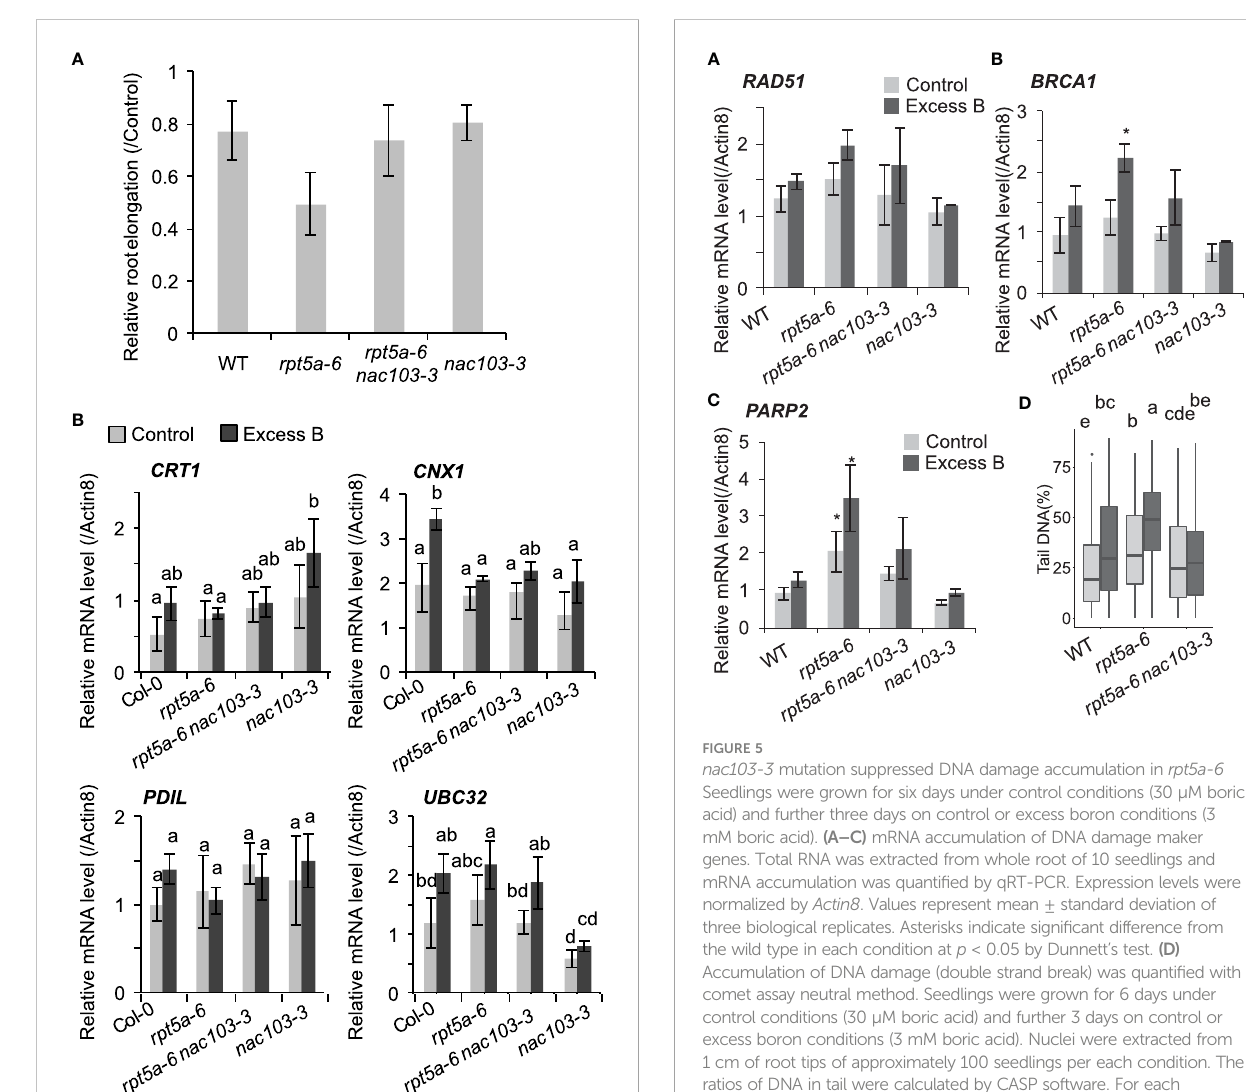
FIGURE 4 Effect of nac103-3 mutation on unfolded stress response (A) Sensitivity to unfolded protein inducible reagent L-canavanine. Seedlings were precultured in normal conditions (30 µM boric acid) for six days and then transferred to 0.5 µM L-canavanine or control conditions. Root elongation during three days after the transfer was measured and normalized by the average elongation under control conditions. Values represent mean ± standard deviation of measurements of 11-15 seedlings. An asterisk indicates signi fi cant difference from the wild type at p < 0.05 by Dunnett ’ s test. (B) mRNA accumulation of NAC103- downstream unfolded protein response related genes, CRT1, CNX1, PDIL1 and UBC32 . Seedlings were grown for 6 days under control conditions (30 µM boric acid) and further 3 days on control or excess boron conditions (3 mM boric acid). Total RNA was extracted from whole root of 10 seedlings and mRNA accumulation was quanti fi ed by qRT-PCR. Expression levels were normalized by Actin8 . Values represent mean ± standard deviation of three biological replicates. Groups sharing the same letters are not signi fi cantly different at p < 0.05 by Tukey ’ s test.